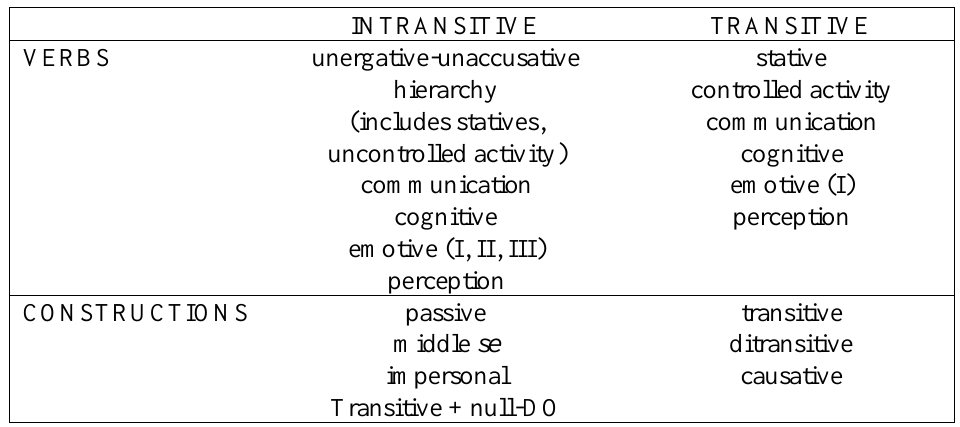
Table 9. Valency coding: intransitive and transitive